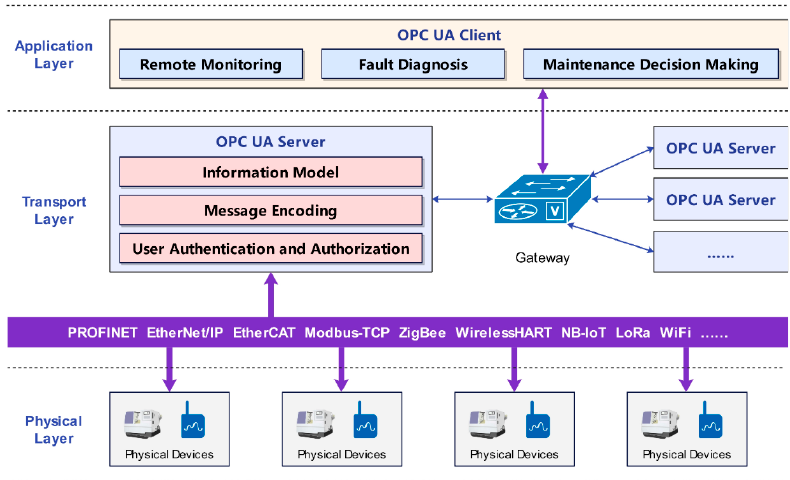
Figure 7. OPC UA-based data acquisition